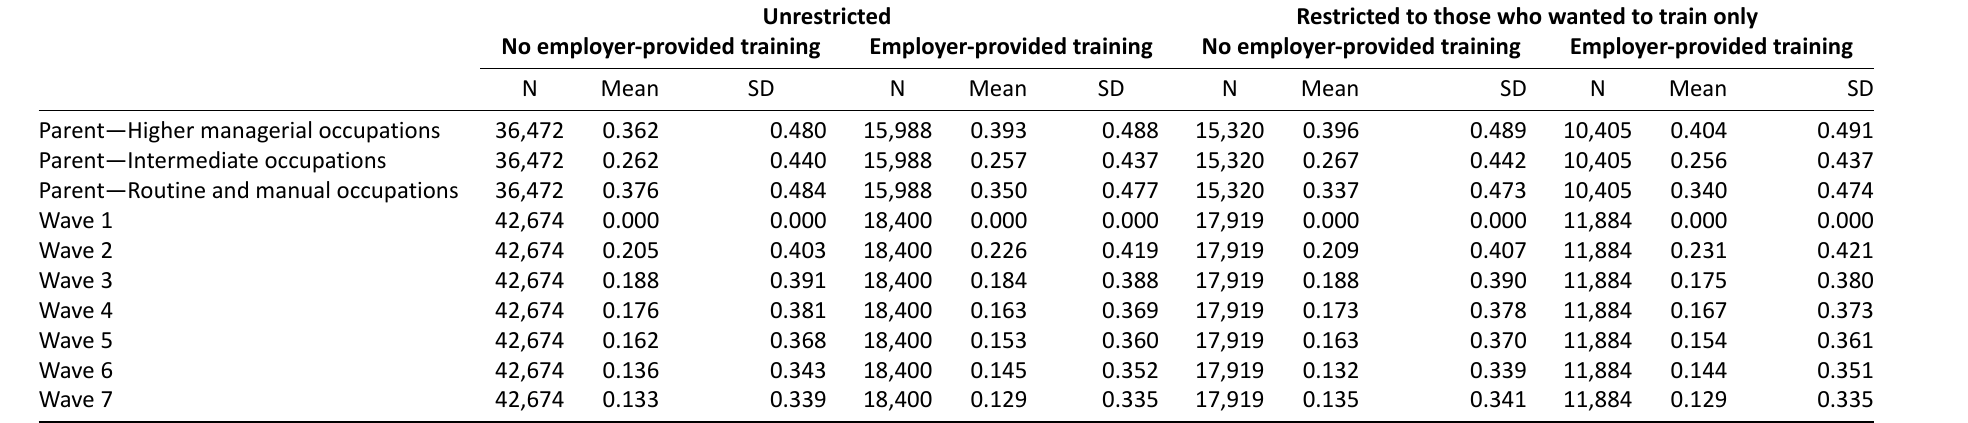
Table A3. (Cont.) Individual characteristics by participation in employer-provided training, unrestricted and restricted samples. Unrestricted Restricted to those who wanted to train only No employer-provided training Employer-provided training No employer-provided training Employer-provided